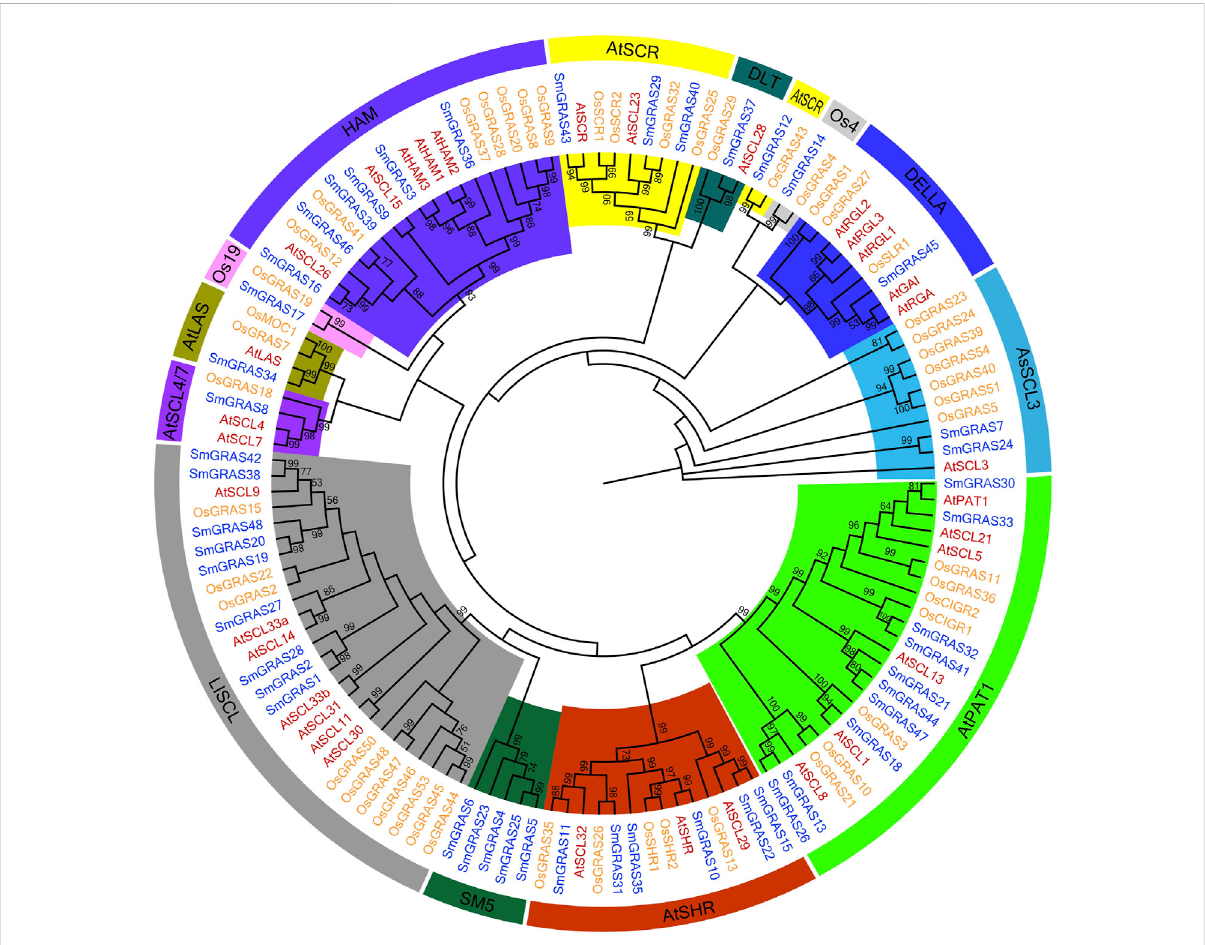
FIGURE 3 Combined phylogenetic analysis of GRAS proteins from Arabidopsis, rice, and eggplant. The rooted maximum likelihood tree was constructed from alignments of131 GRAS proteinsequences from Arabidopsis (33), rice (50),and eggplant(48) under theLG + G + Fmodel with 1,000 bootstrap replications. Bootstrap values above 50% are shown. For each subfamily, bootstrap values are shown in different